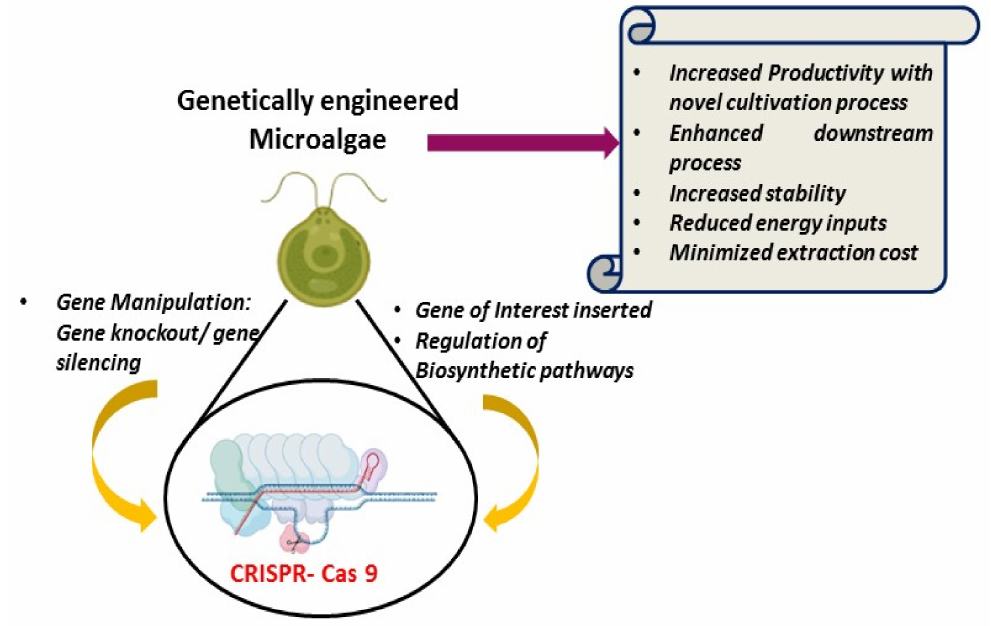
Figure 1. Genetically modified microalgae improve lipid